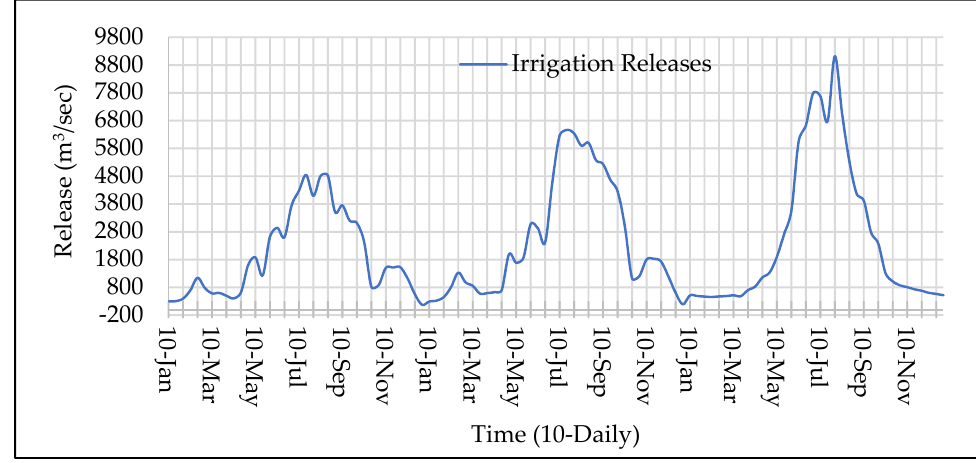
Figure 25. Irrigation releases from Tarbela Reservoir for application years (2025, 2030 and 2035).